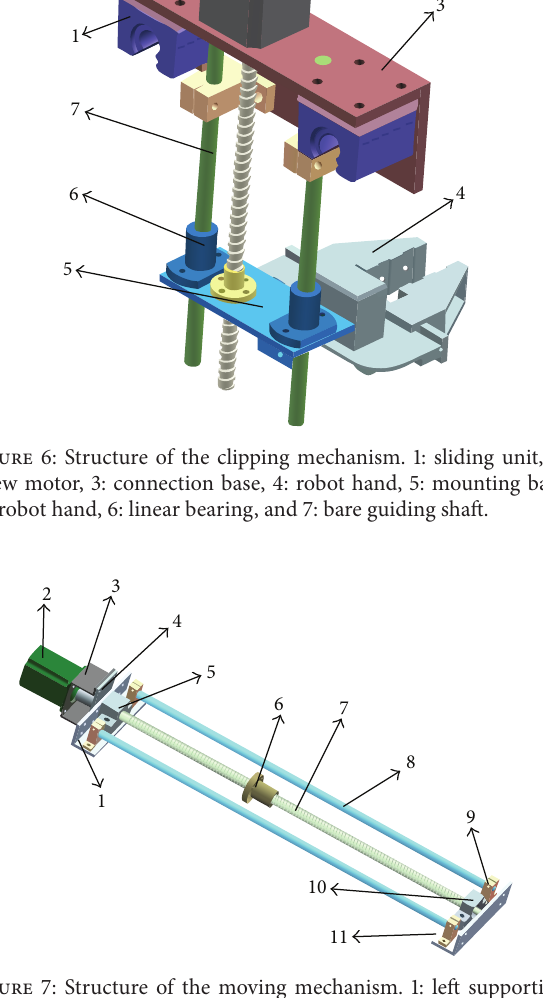
Figure 7: Structure of the moving mechanism. 1: left supporting base, 2: driving motor, 3: motor mounting base, 4: motor connection board, 5: front screw mounting base, 6: driving screw nut, 7: driving screw, 8: bare guiding shaft, 9: bare supporting base, 10: rear screw mounting base, and 11: right supporting